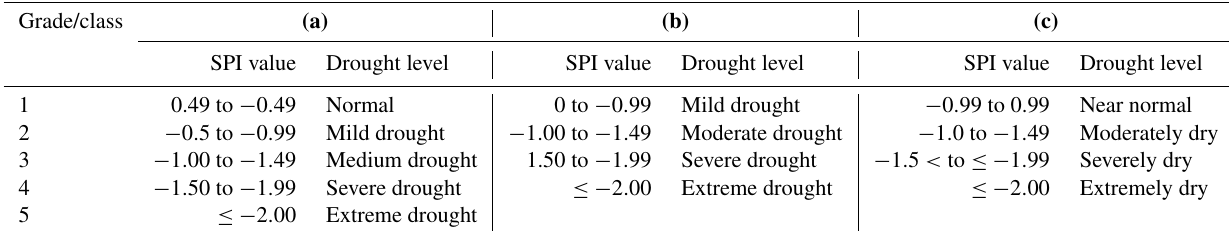
Table 3. SPI drought classifications applied within different regions. (a) Chinese grades of meteorological drought (National Standards of the People’s Republic of China, 2017) and (b) the arbitrary drought intensity classes originally defined by Mckee et al. (1993) and (c) as used by the WMO (World Meteorological Organization; WMO,